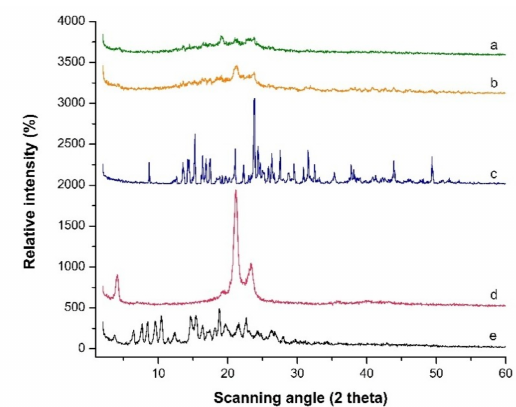
Figure 6. PXRD patterns scanned from 2 ◦ to 60 ◦ 2 θ at a rate of 5 ◦ C/min for ( a ) Freeze-dried LPV-NLC-7-Tres formulation, ( b ) Blank formulation, ( c ) Trehalose, ( d ) Compritol 888 ATO ® and ( e )